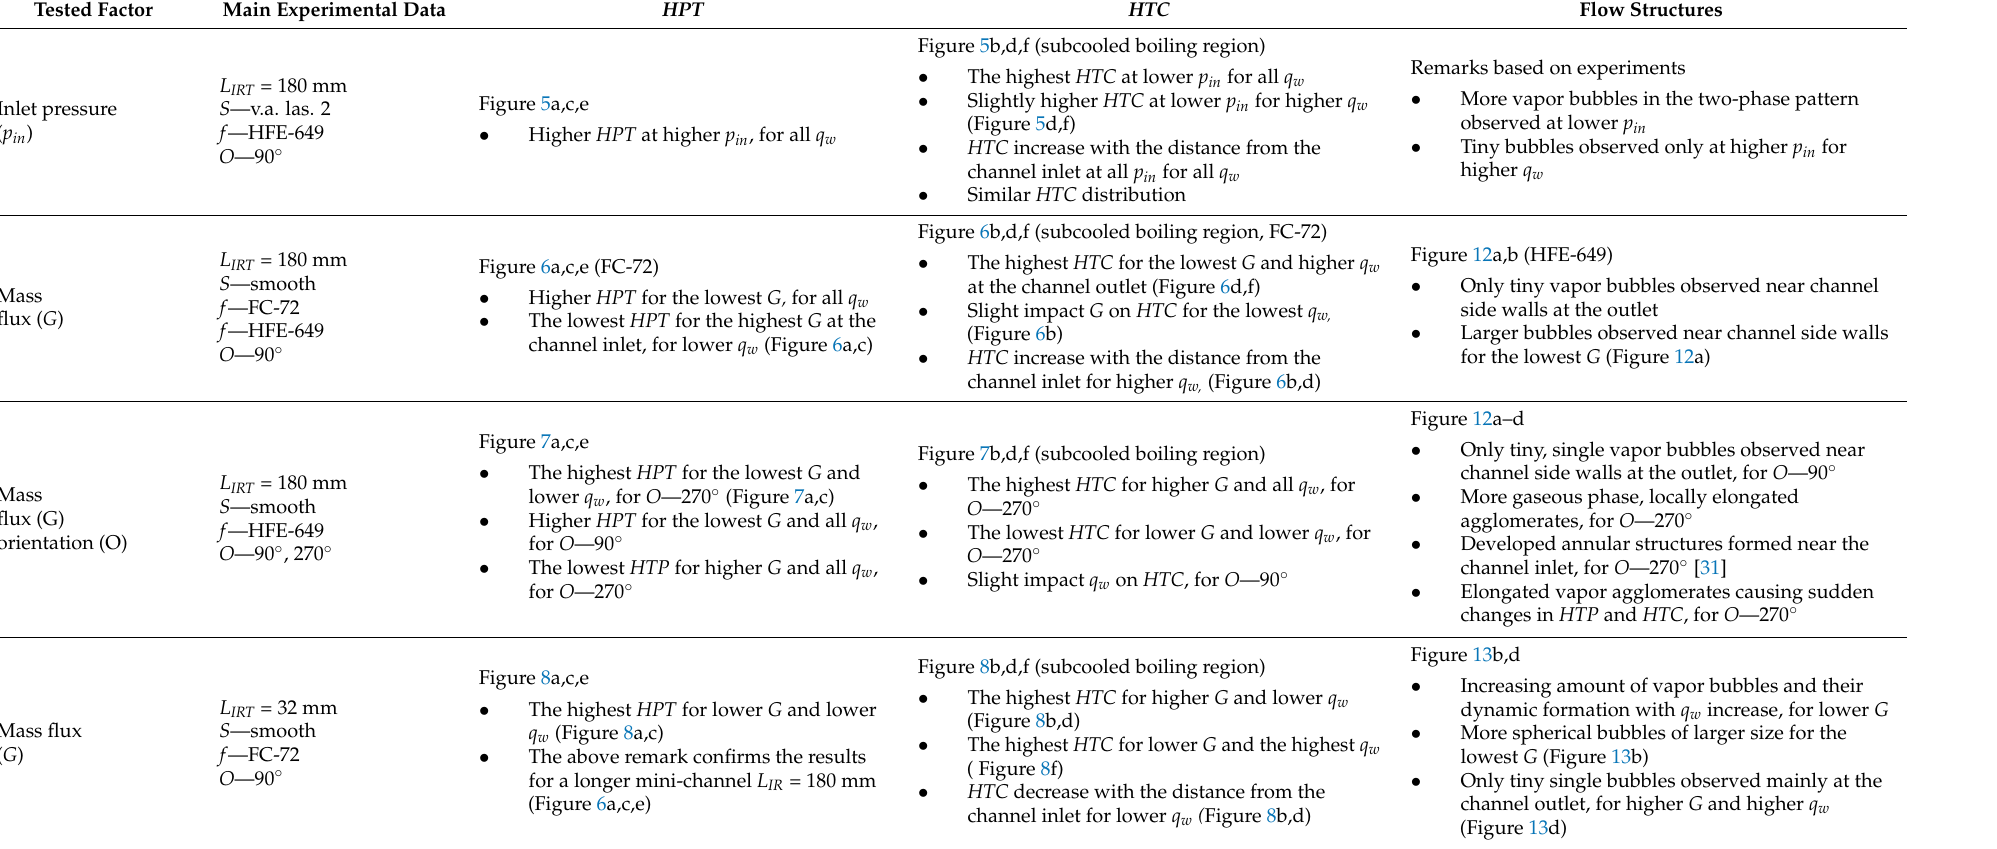
Table 6. Characteristics of the influence of selected factors on flow boiling in